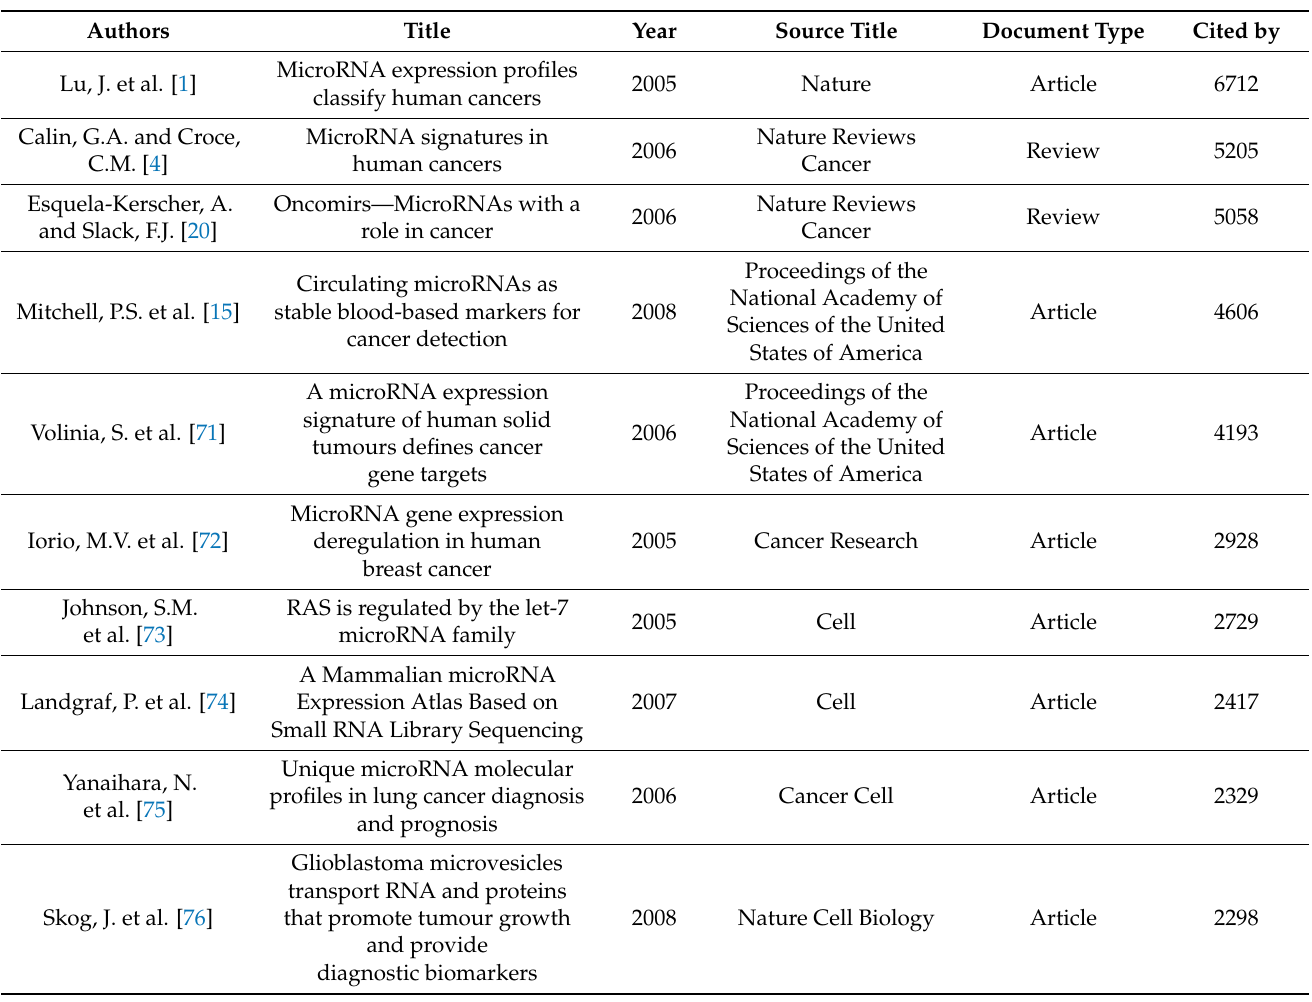
Table 6. Top 10 cited articles on miRNA in cancer